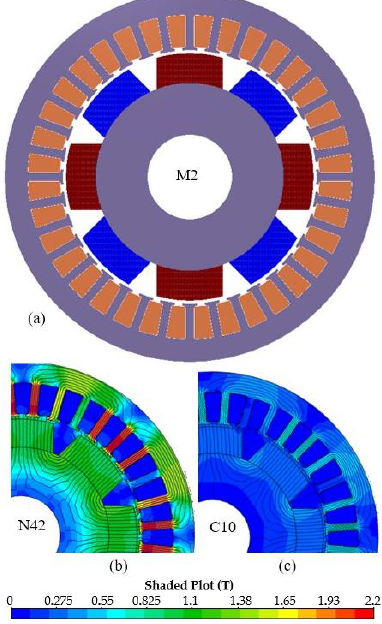
4 of 15 Figure 1. Tangential machine: ( a ) general view, ( b ) magnetic flux density in the stator and rotor core of N42 PM machine, ( c ) magnetic flux density distribution in the stator and rotor core of C10 PM machines.